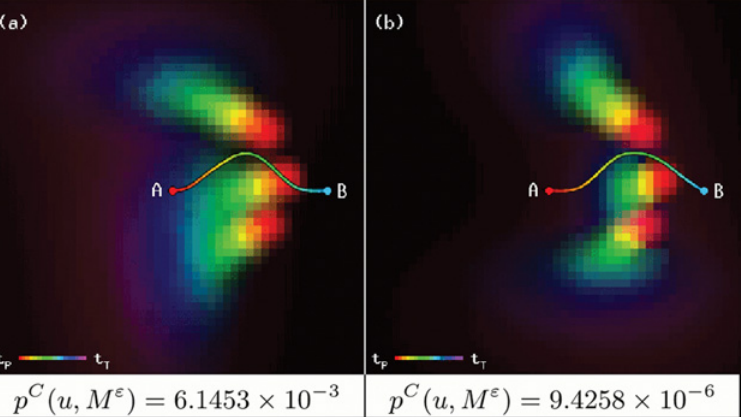
Fig 4. Trajectory calculation for the original examples using passive (a) and active (b) objects. We use T = 35 and (cid:2) = 10 − 3 ; in both cases, T u = 21 and k u k = 24.142.